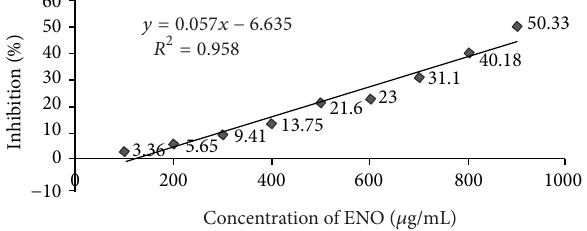
Probit analysis